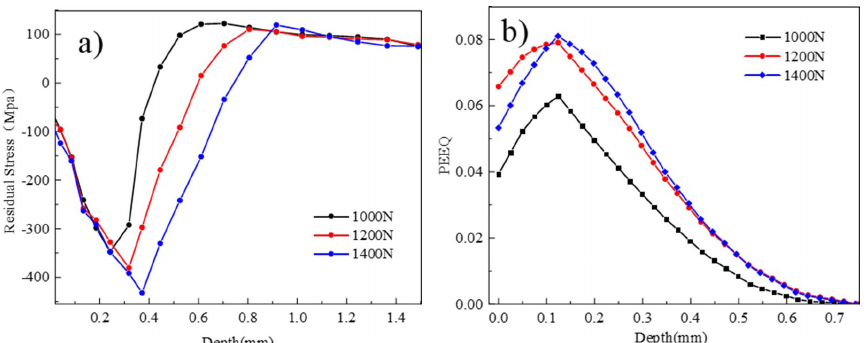
Figure 5. Distribution of residual stress and equivalent plastic strain along the depth direction under different static loading forces (1000N, 1200N, 1400N).